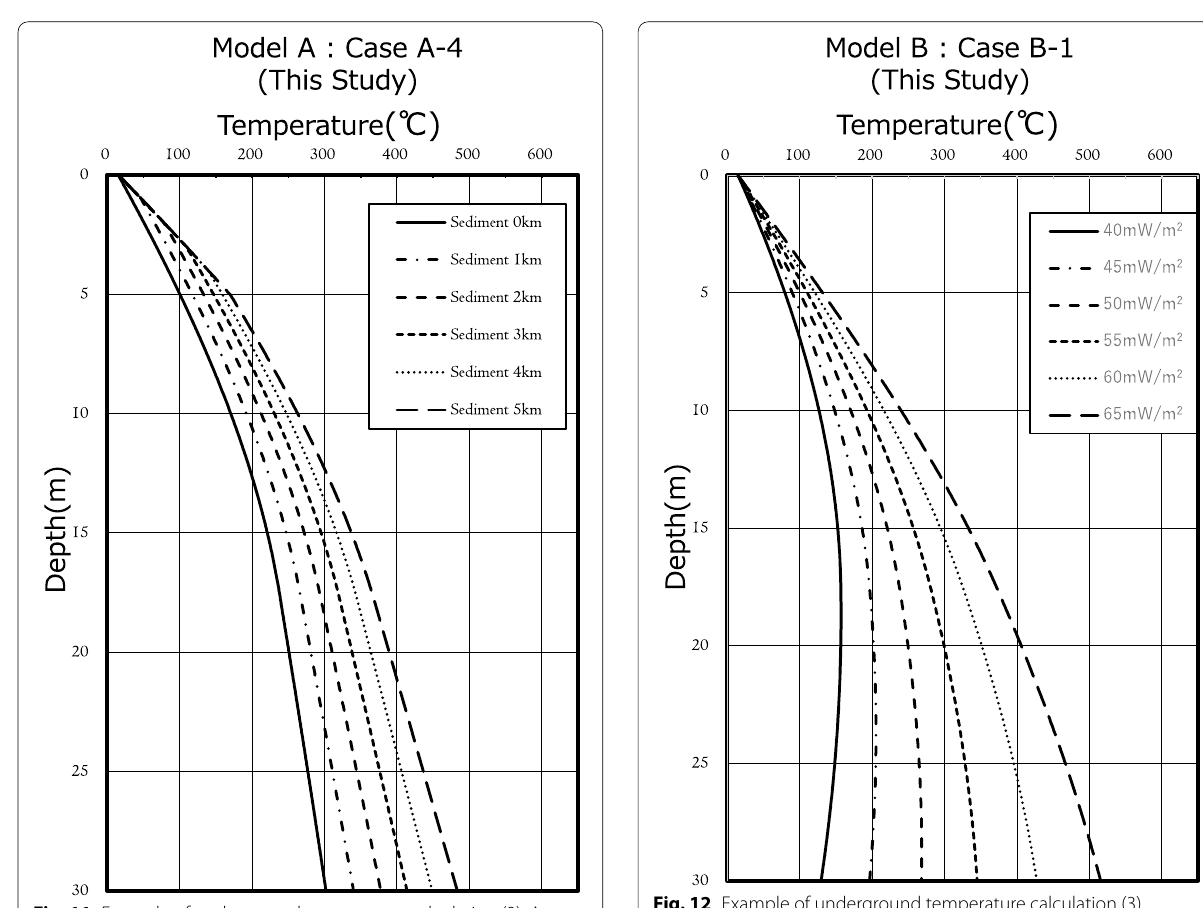
Fig. 11 Example of underground temperature calculation (2). An example calculation shows the effect of a sedimentary layer. The heat flow is 50 mW m − 2 . The crustal structure corresponds to Model A (Case A-5) in Fig. 9(a)